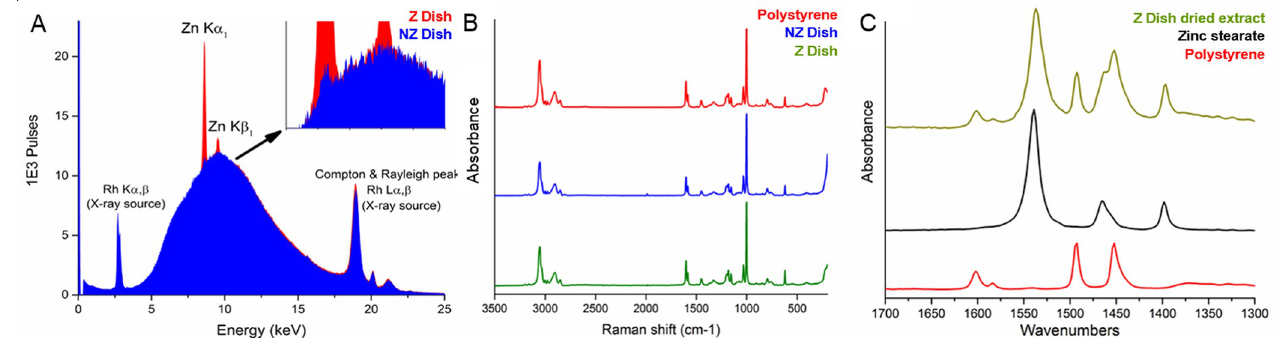
Fig 2. Materials characterization of plastic culture dishes. A) X-Ray fluorescence comparison of zinc presence between non-Zinc dishes (blue) and Zinc dishes (red). B) FT-Raman comparison of a polystyrene reference spectrum (top/red) with a non-Zinc dish (center/blue) and Zinc dish (bottom/green). Intact culture dishes were made of polystyrene but did not reveal any other noticeable structural differences. C) FTIR spectra of the Zinc dish dried extract (top/ green), zinc stearate powder (center/black) and polystyrene reference (bottom/red).